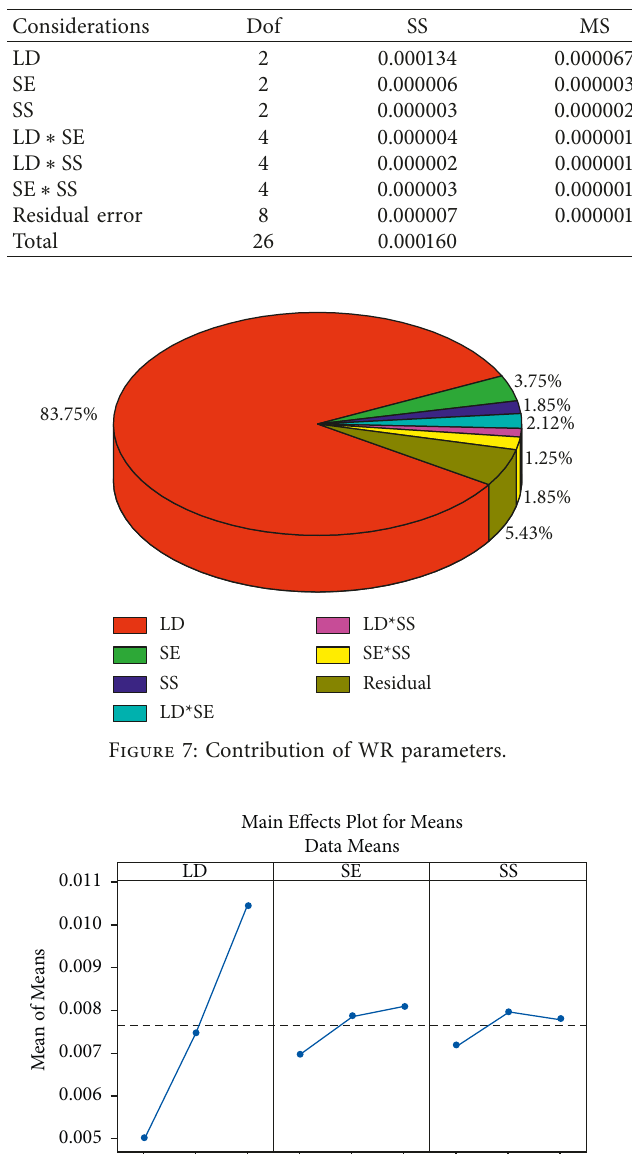
Table 3: ANOVA wear rate.